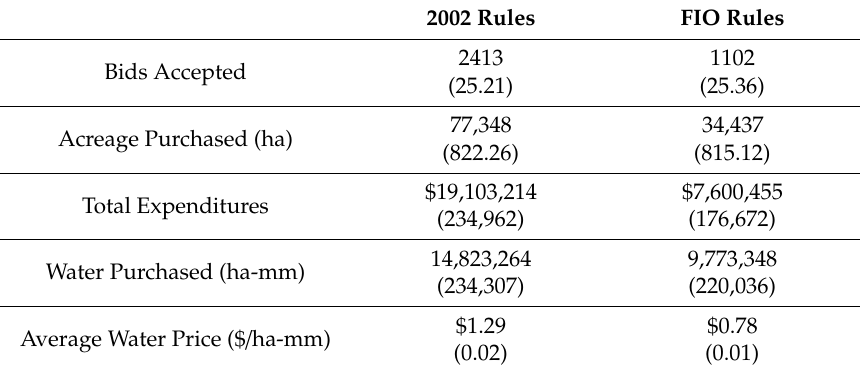
Table 3. Simulation results with unconstrained auction budget.